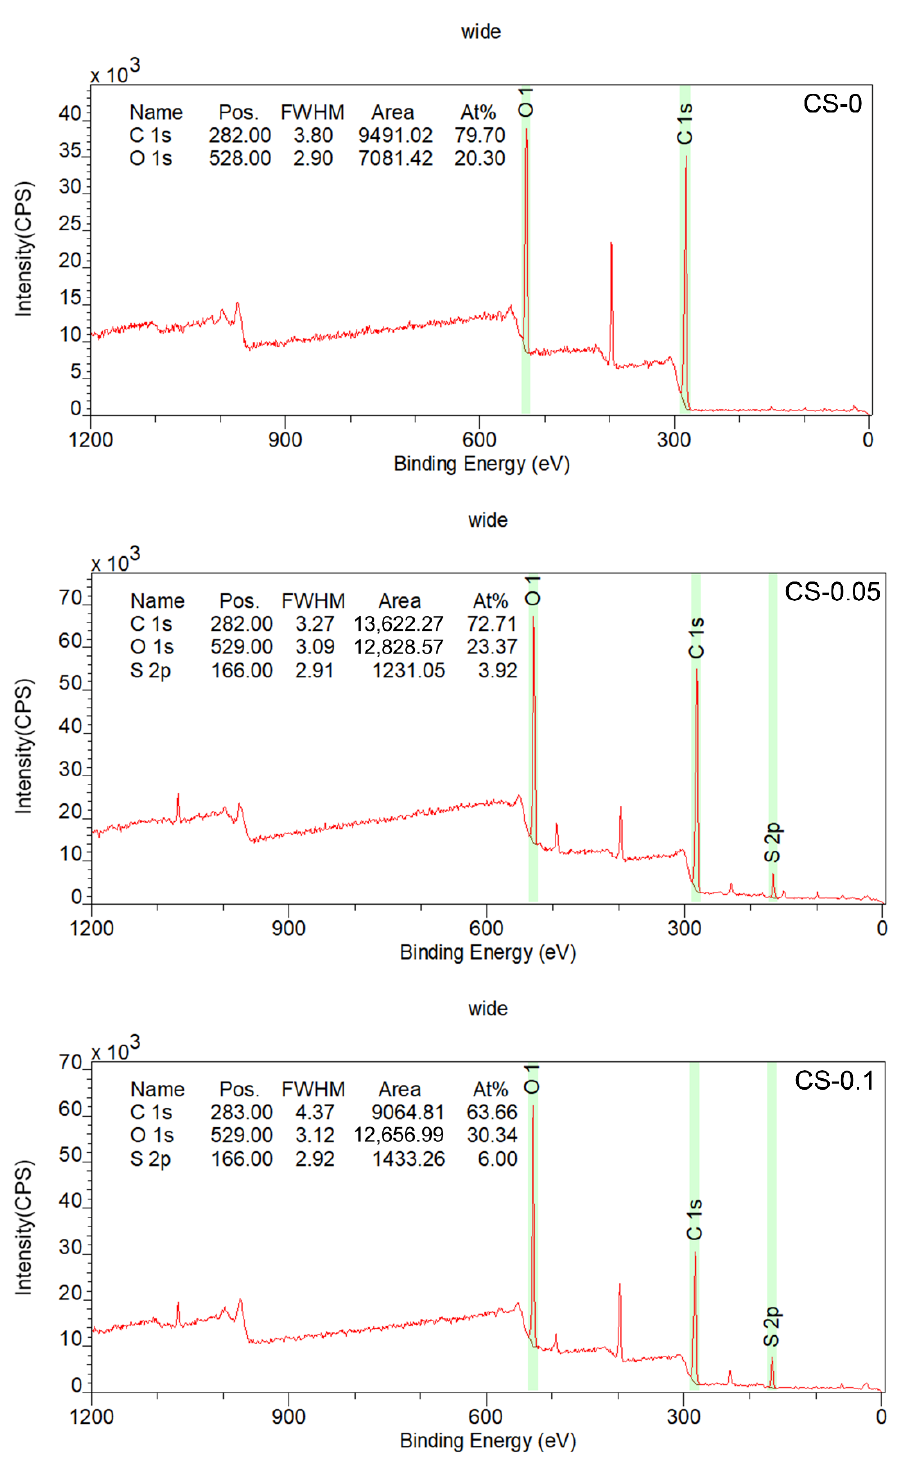
Figure 4. XPS spectra of the hydrogels. The release properties of CS from the hydrogels was quantified using the Azure A staining method. Azure A is a cationic dye, and a discoloration effect can occur through electrostatic interaction between Azure A and sulfate radicals in CS [22]. Therefore, the hydrogel extract, which is the initial blue color in the CS-0 group, changes to a bluish- purple color when Azure A is added to the CS-0.05 and CS-1 groups (Figure 5a). The re- lease profiles of CS were determined, and are in Figure 5b. The profiles of the CS-0.05 and